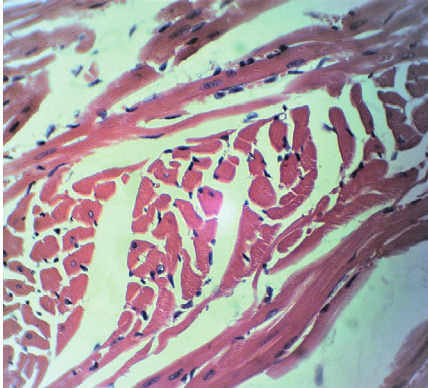
Figure 5: A photomicrograph of a cross-sectional representative of a DOX-intoxicated rat heart treated with 400mg/kg/day CVE showing near normal myocytes with very scanty meganuclei in- dicating no remarkable histological changes ( × 400 magnification, hematoxylin-eosin stain).